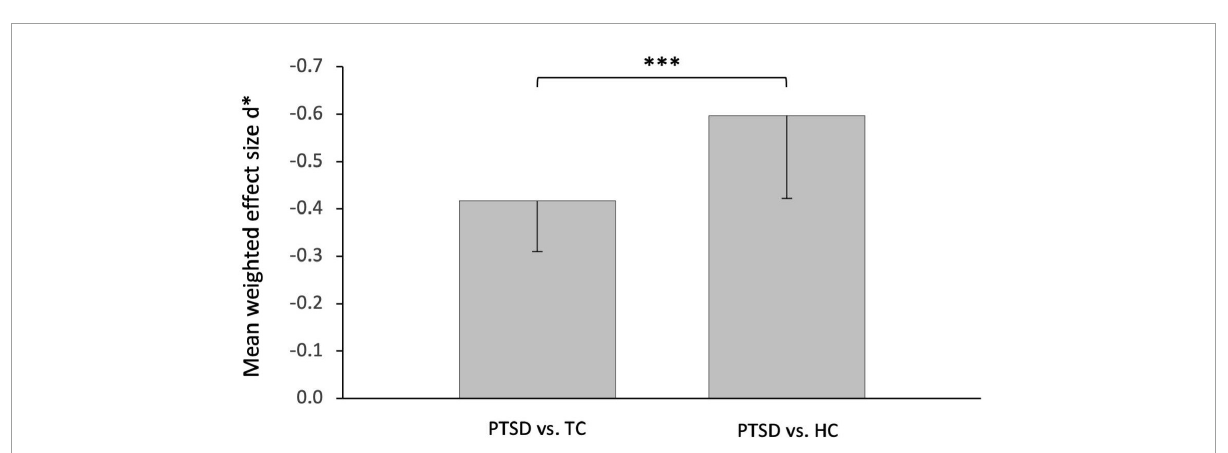
FIGURE3 Effect of the control group. Significantly greater impairment of episodic memory in post-traumatic stress disorder patients compared with non-traumatized healthy controls (HC, right ) than compared with trauma-exposed controls (TC, left ). ∗∗∗ p <